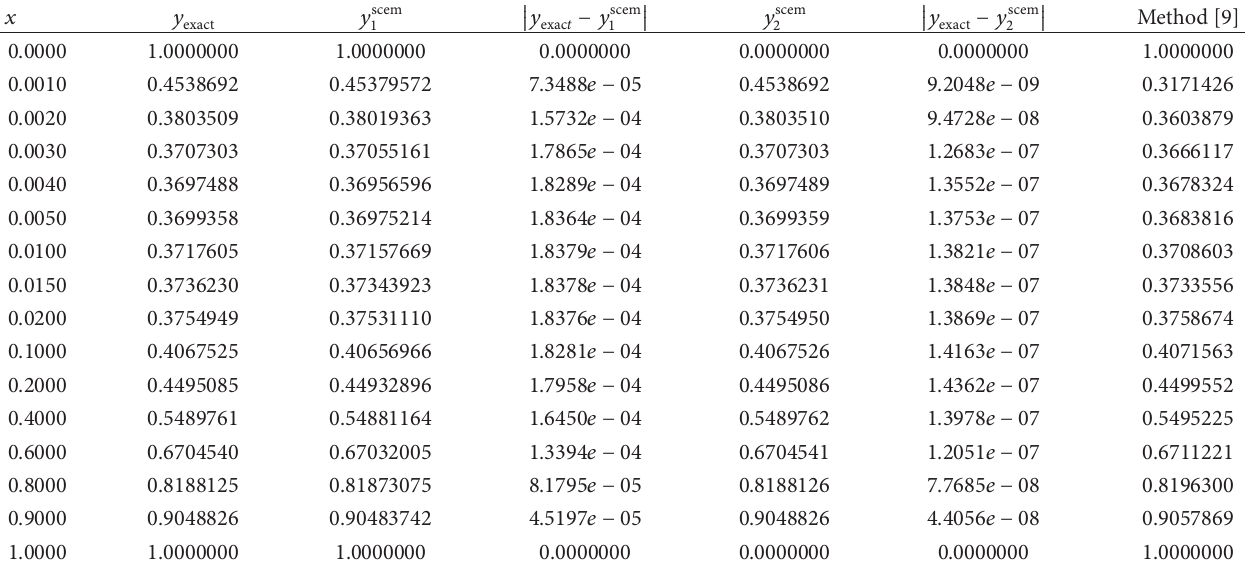
Table 1: Results of left layer problem for 𝜀 = 10 −3 and 𝛿 = 0.5𝜀 .